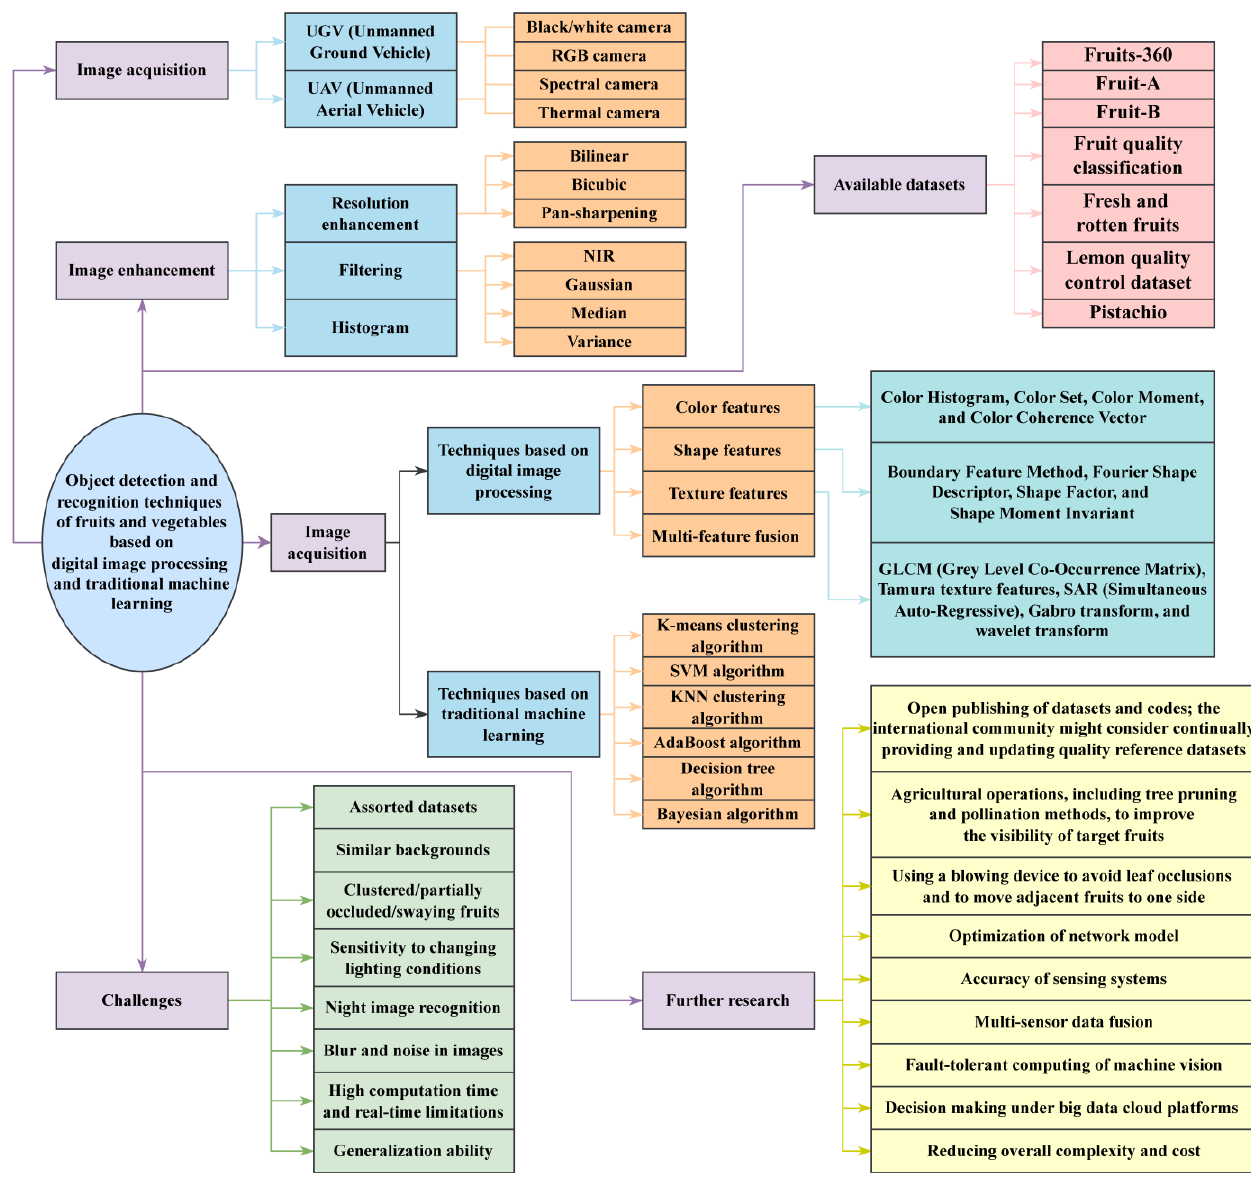
Figure 4. The outline of this overview and review.